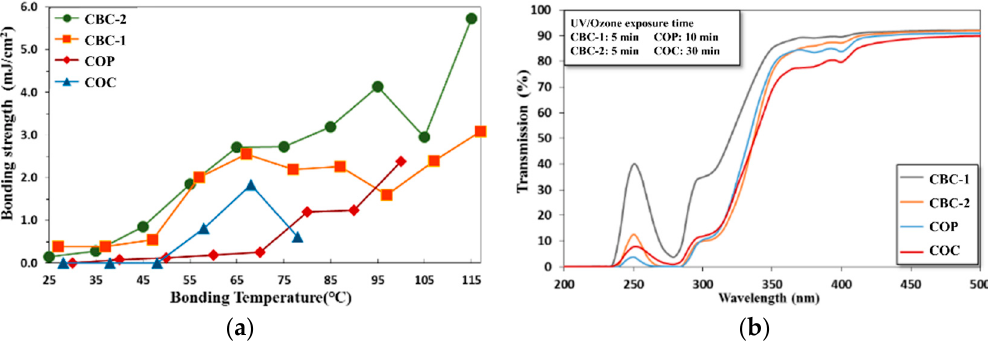
Figure 8. ( a ) UV/ozone bonding strength and ( b ) ultraviolet-visible light (UV-VIS) transmissivity after UV/ozone treatment for CBC-1, CBC-2, COP, and COC substrates. The bonding strength values are the average of three individual measurements.